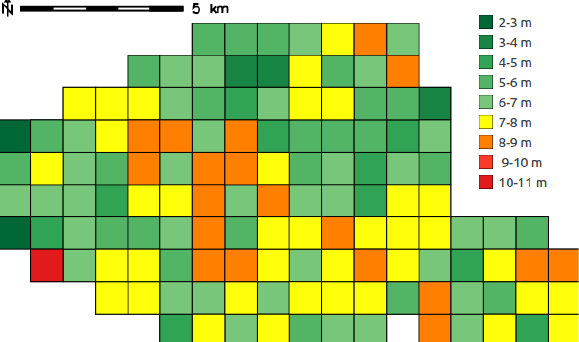
Figure 3. Maximum deviation of the Paris OSM dataset from the IGN dataset for each grid